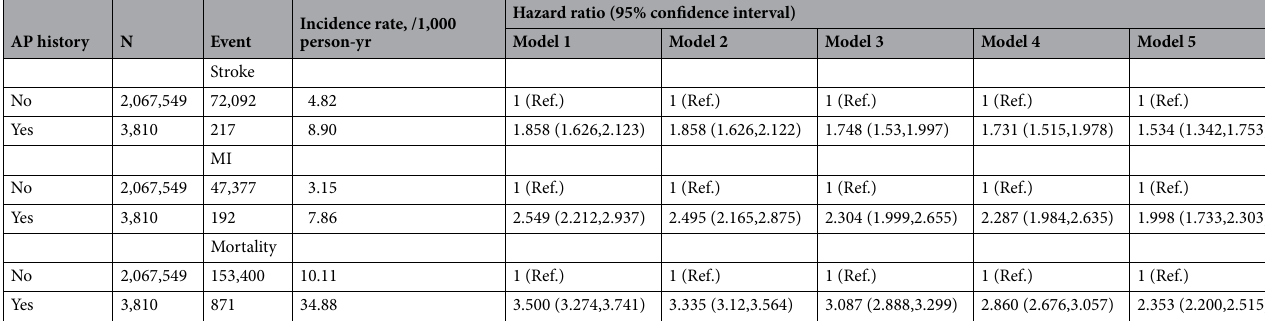
Table 2. Risk of stroke, myocardial infarction, and mortality according to acute pancreatitis history. Model 1, unadjusted; Model 2, adjusted for age and sex; Model 3, adjusted for model 2 + smoking, alcohol drinking, regular exercise, and income level; Model 4, adjusted for model 3 + hypertension, dyslipidemia, and body mass index; Model 5, adjusted for model 4 + diabetes duration, use of insulin, and prescription of two or more oral diabetic agents. AP acute pancreatitis; MI , myocardial